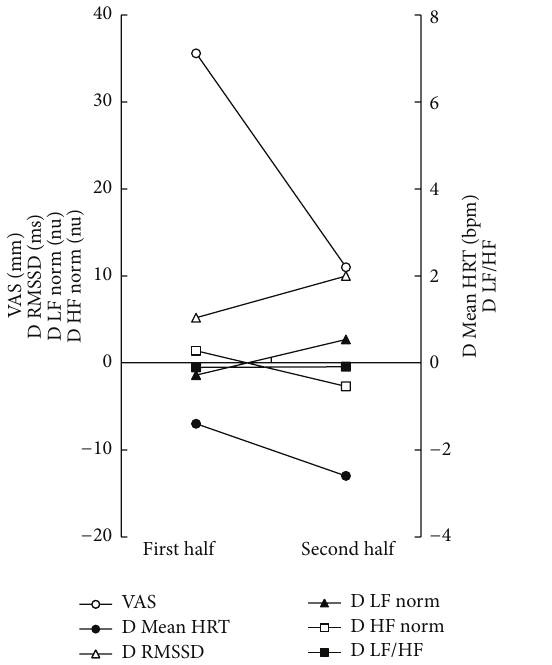
Figure 2: Time course of differential frequency-/time-domain parameters during SGR in case 2.